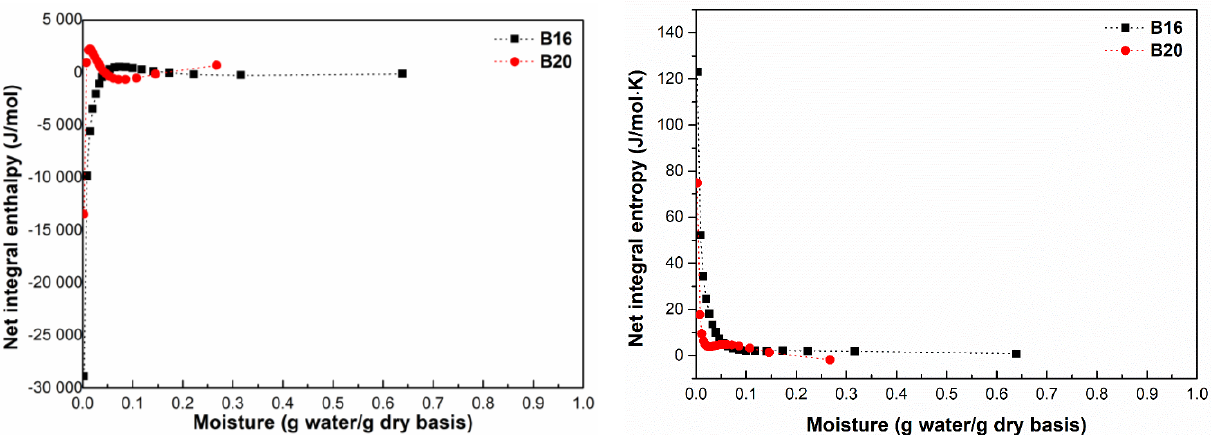
Figure 7. Net integral enthalpy and entropy of adsorption as a function of equilibrium moisture content for B16 and B20.